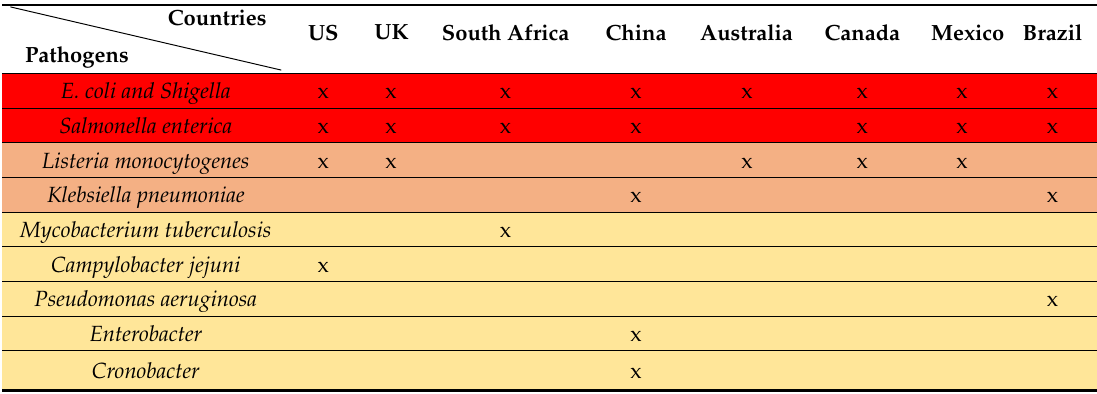
Table 3. Highest occurring AMR pathogens sorted and color coded by their presence in each country (the US, the UK, South Africa, China, Australia, Canada, Mexico, and Brazil). Note: red indicates AMR pathogen presence in 7–8 out of the 8 countries; orange indicates AMR pathogen presence in 2–5 out of the 8 countries; and yellow indicates the AMR pathogen presence in 1 out of the 8 countries.